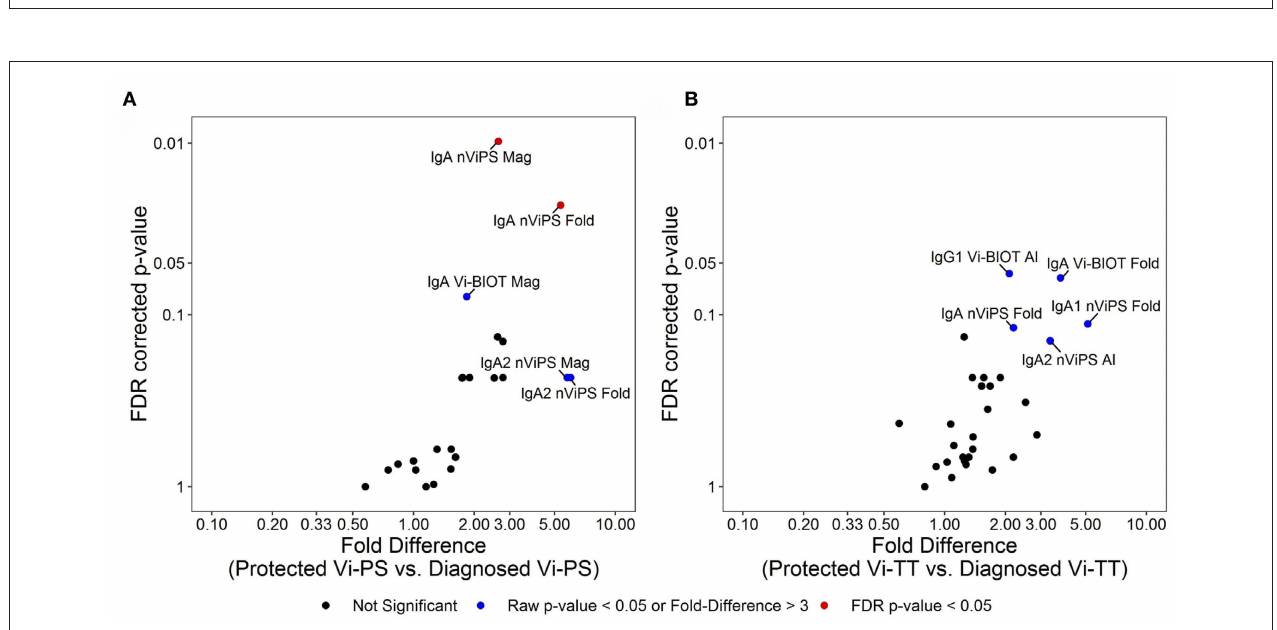
FIGURE 6 | Different immune signatures of protection status for Vi-PS and Vi-TT. Variables in analysis of immune signatures between vaccine groups include magnitude, fold-change, and avidity of IgA1, IgA2, IgG1, IgG2, and IgG3 to Vi-Biot and nViPS. Volcano plot of FDR-corrected p -value and fold difference by diagnosed/protected outcome for Vi-PS vaccinees (A) and Vi-TT vaccinees (B) . Red dots represent FDR-corrected p -values < 0.05, blue dots represent raw p -values < 0.05 or fold difference > 3